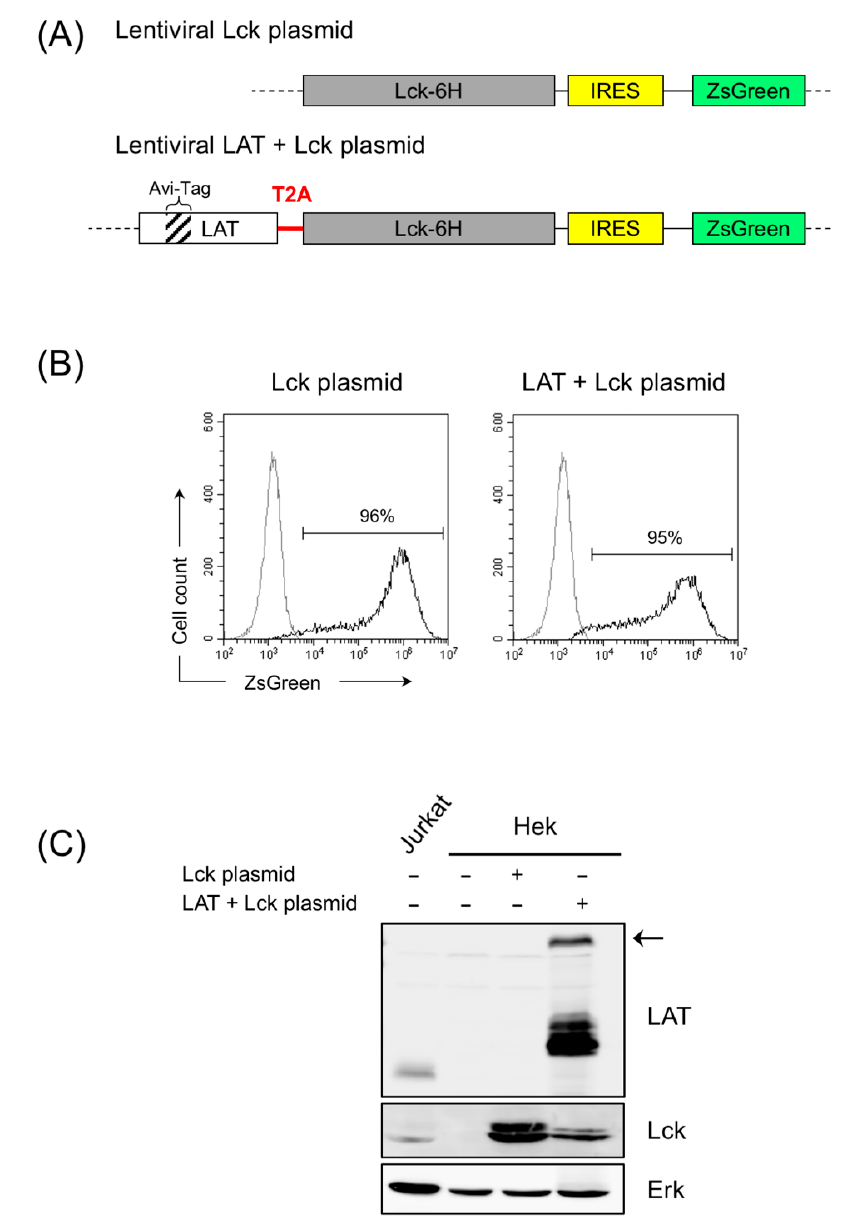
Figure 4 . Transfection of lentiviral plasmids coding for Lck or LAT plus Lck in Hek Lenti-X cells. ( A ) Schematic representation of the coding regions included in the lentiviral plasmids generated for the expression of Lck or LAT plus Lck. The T2A sequence between LAT and Lck is indicated in red. ZsGreen reporter is located after the Lck-6His fusion gene and an IRES sequence in both plasmids. ( B ) 72 h after the transfection of the HEK Lenti-X packaging cell line, the expression of the reporter ZsGreen was determined by flow cytometry. Numbers indicate the percentage of ZsGreen positive cells (black line). Gray line corresponds to untransfected HEK Lenti-X cells. ( C ) LAT and Lck expression was analyzed in Jurkat or HEK Lenti-X cells untransfected or transfected with the indicated plasmids. Lysates obtained from 10 6 cells were analyzed by Western blot with the indicated specific antibodies. Arrow on the right indicates the LAT-Lck fusion protein.